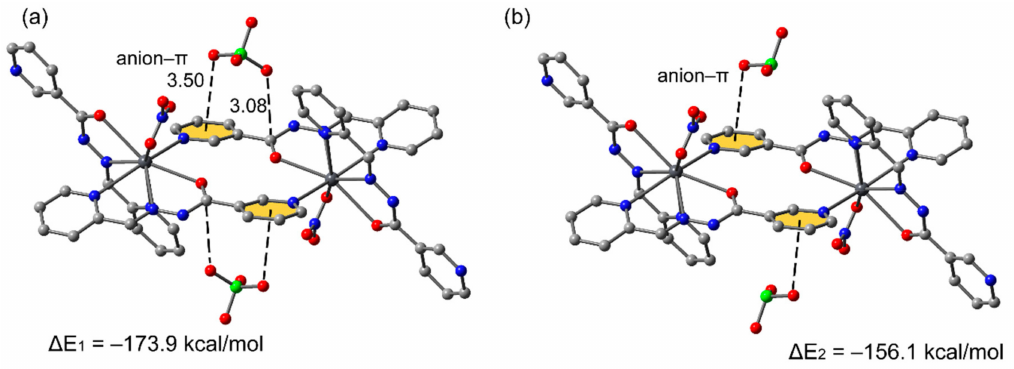
Figure 10. ( a , b ) Theoretical models of compound ( 1 ) (distances in Å). H-atoms are not shown for clarity.